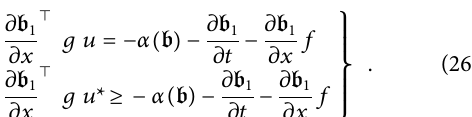
Frontiers in Robotics and AI |